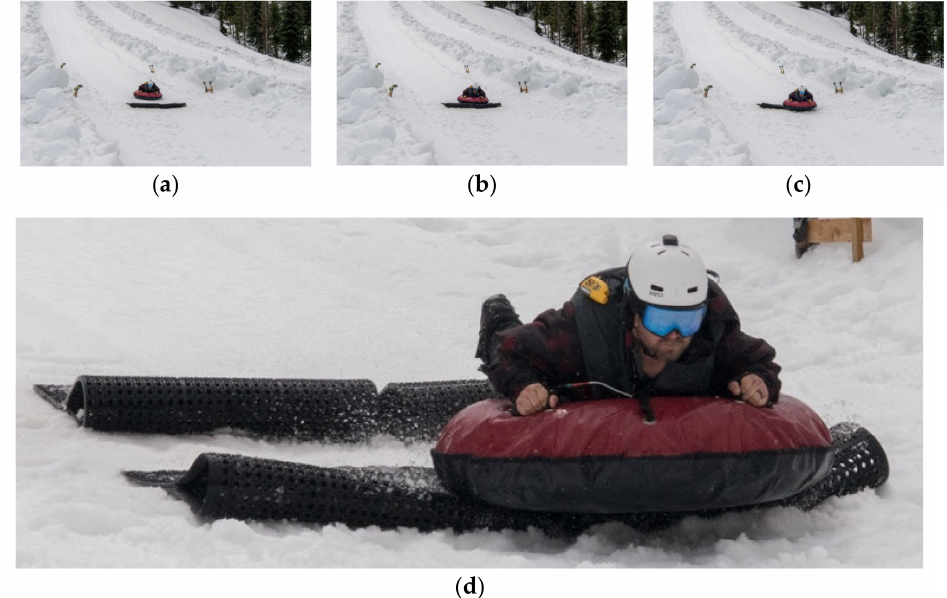
Figure 3. ( a – c from left to right ) Participant descending the snow tube run and traversing the deceleration mats that were in the folded configuration. When the deceleration mats were folded (regardless of the side— ribs or projections —presenting to the snow tube), the snow tube and rider compressed the folded section as they moved past. ( d ) Close-up of the compression of the folded portion of a deceleration